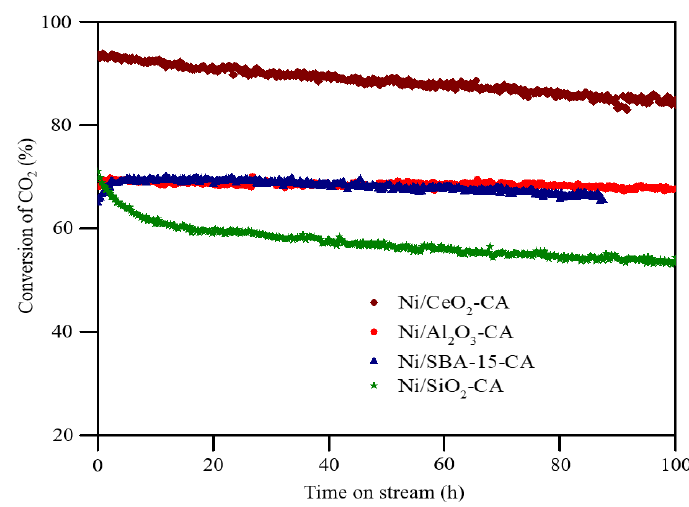
Figure 9. Stability test over different catalysts: Reaction temperature = 325 °C, H 2 :CO 2 :CH 4 = 4:1:1, WHSV = 45 L/h g catalyst and pressure = 12.5 bar.